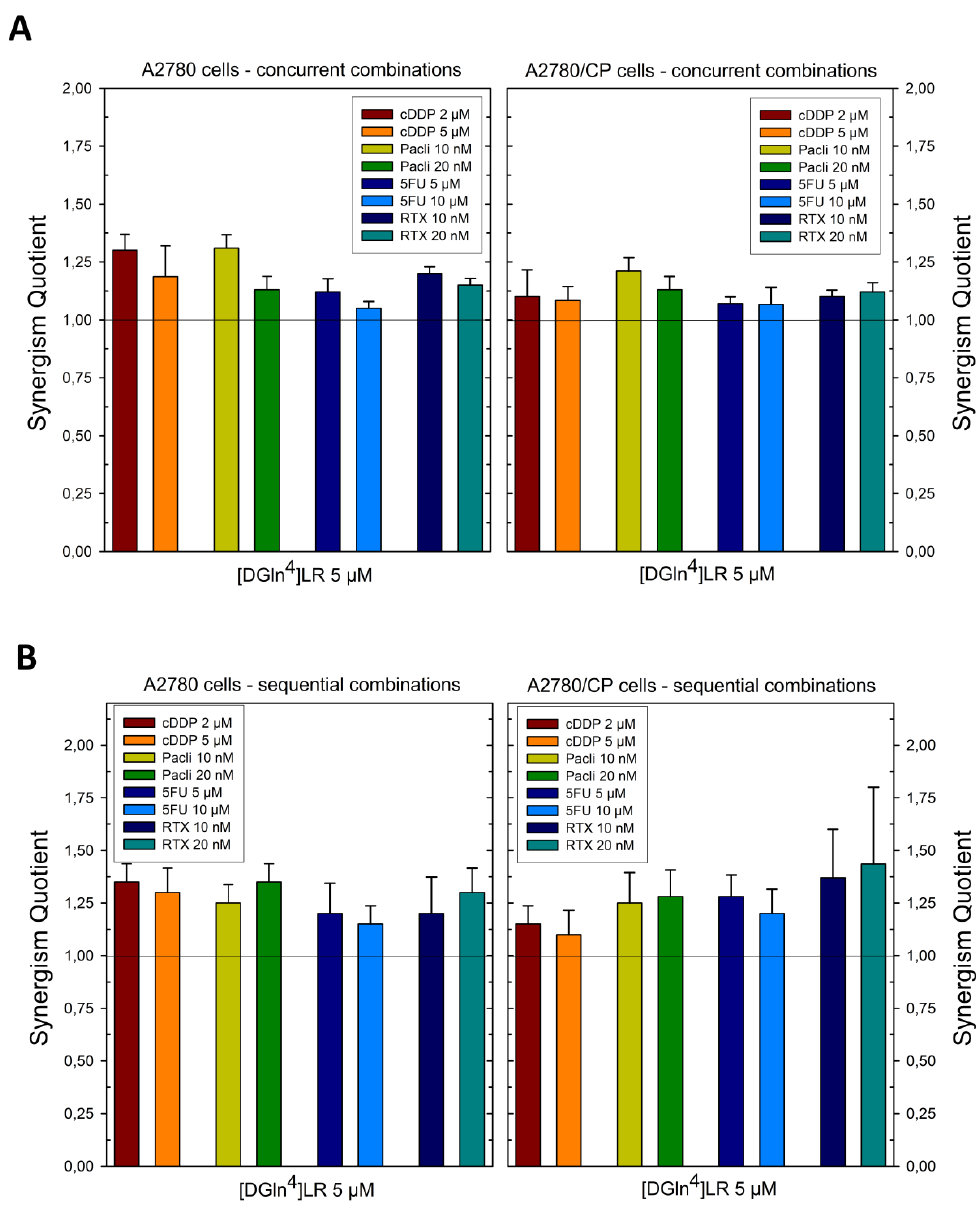
Figure 1. E ff ects of scheduled combinations of the [D-Gln4]LR peptide with cDDP, paclitaxel, 5FU and RTX on the SQ values in A2780 and A2780 / CP cell lines. ( A ) concurrent combinations for 72 h. ( B ) Sequential combinations, as described in Section 4. The bars represent the mean of duplicate cell counts on three separate experiments and indicate the result of the inhibition of drug combination divided by the sum of the inhibition of a single drug to obtain the values of SQ. Error bars, SD. With the second pair of cell lines, 2008 and C13*, concurrent administration was additive for cDDP, 5-FU, and paclitaxel at the lower dose, supra-additive at the higher dose of paclitaxel and for RTX at both doses (Figure 2 and Figure 4). Sequential exposure to [D-Gln 4 ]LR and then to the drugs did not enhance cell killing with the cDDP-sensitive 2008 cells with respect to the concurrent administration. On the contrary, with the resistant C13* cells both 5-FU and RTX increased their cytotoxicities when administered after [D-Gln 4 ]LR; in particular, RTX exhibited a synergistic e ffi cacy